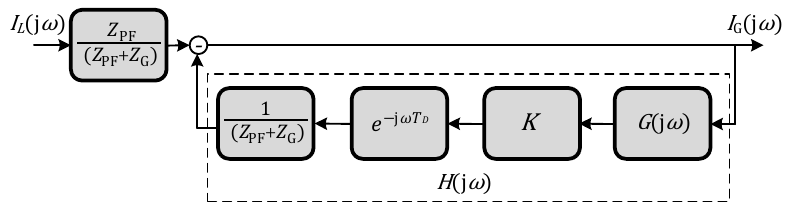
Figure 13. Frequency model used in stability analysis.